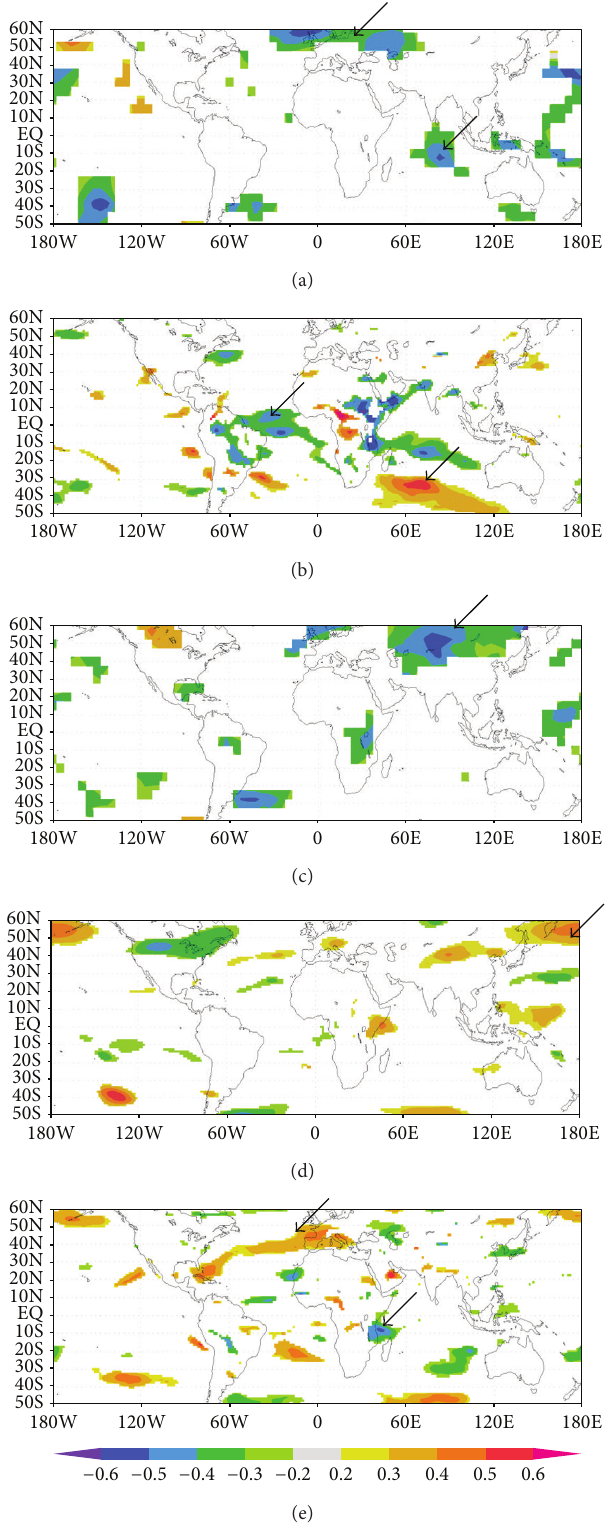
Figure 3: Correlation of MJJ northern rain with DJF predictors: (a) Tsand(b)850 Ufields.CorrelationofASOnorthernrainwithMAM predictors: (c) Ts, (d) 200 U, and (e) 850 U fields 1983–2012. Values below 80% significance are masked here and in Figures 4–6; arrows highlight predictors